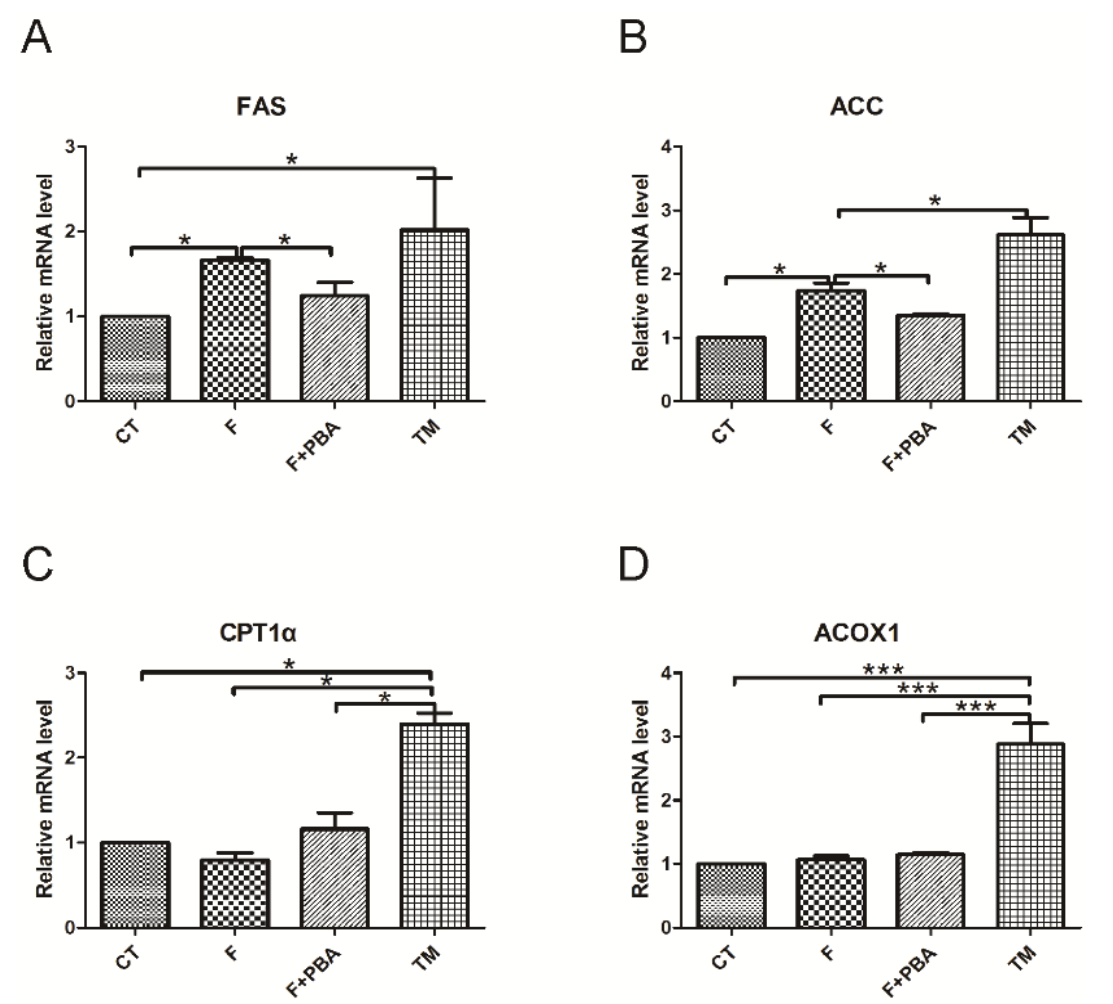
Figure 4. ER stress response mediated hepatic steatosis. CT: control; F: fructose; F + PBA: fructose plus PBA pretreatment; TM: tunicamycin. Expression values were normalized to control group. Data are expressed as mean ± SEM ( n = 4). Data of the four groups were compared by ANOVA with LSD’s test (* p < 0.05, *** p < 0.001).